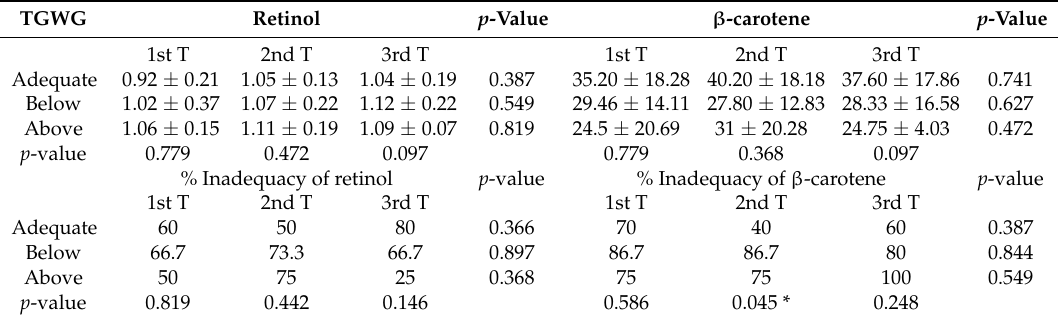
Table 3. Percentage of inadequacy and means of serum concentrations of retinol and β -carotene according to total gestational weight gain, per trimesters of pregnancy.